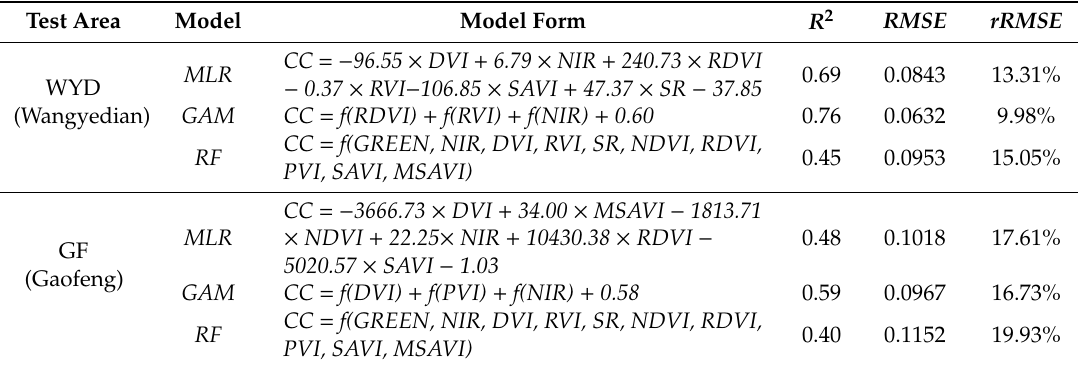
Table 4. Three models and tests established in the two study